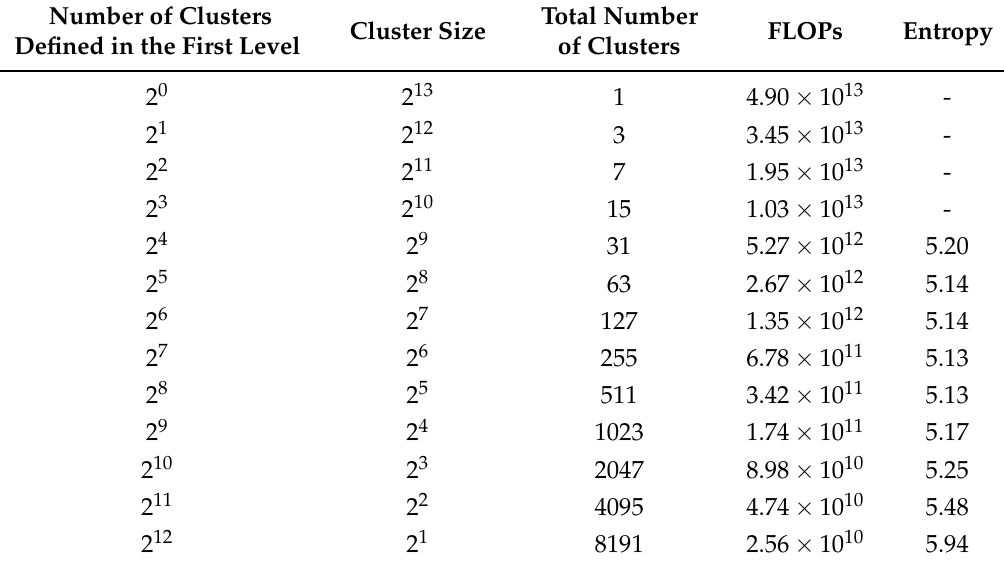
Table 6. Computational cost (in FLOPs) and transform performance (entropy) for different cluster sizes of Multilevel Clustering RKLT. Transform performance results are not provided when 2 0 , 2 1 , 2 2 , and 2 3 clusters are defined in the first level. For these cases, applying the spectral transform would require several days due to the high computational cost, which results impractical in a real